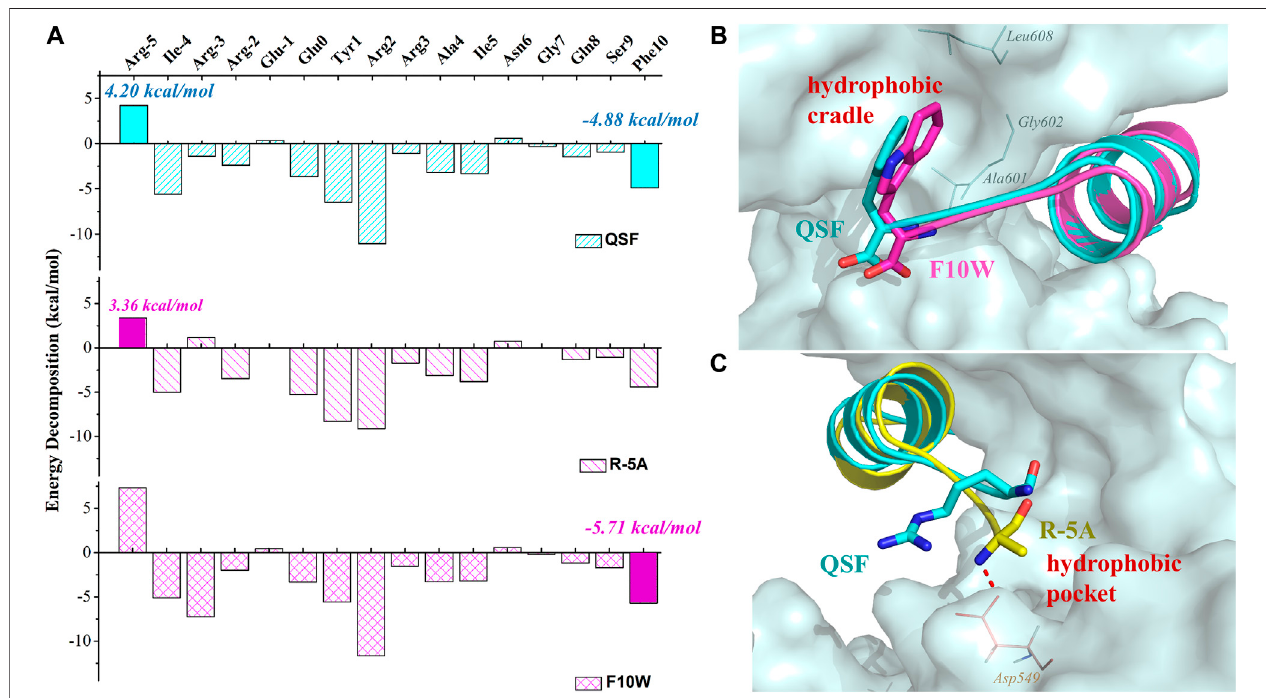
FIGURE4|(A) BindingfreeenergydecompositionofQSF,R(-5)A,andF10Wsystems. (B) SuperpositionoftheMDequilibriumconformationsofQSFandF10W. (C) Superposition of the MD equilibrium conformations of QSF and R (-5)A. The hydrogen bond was shown in red dashed